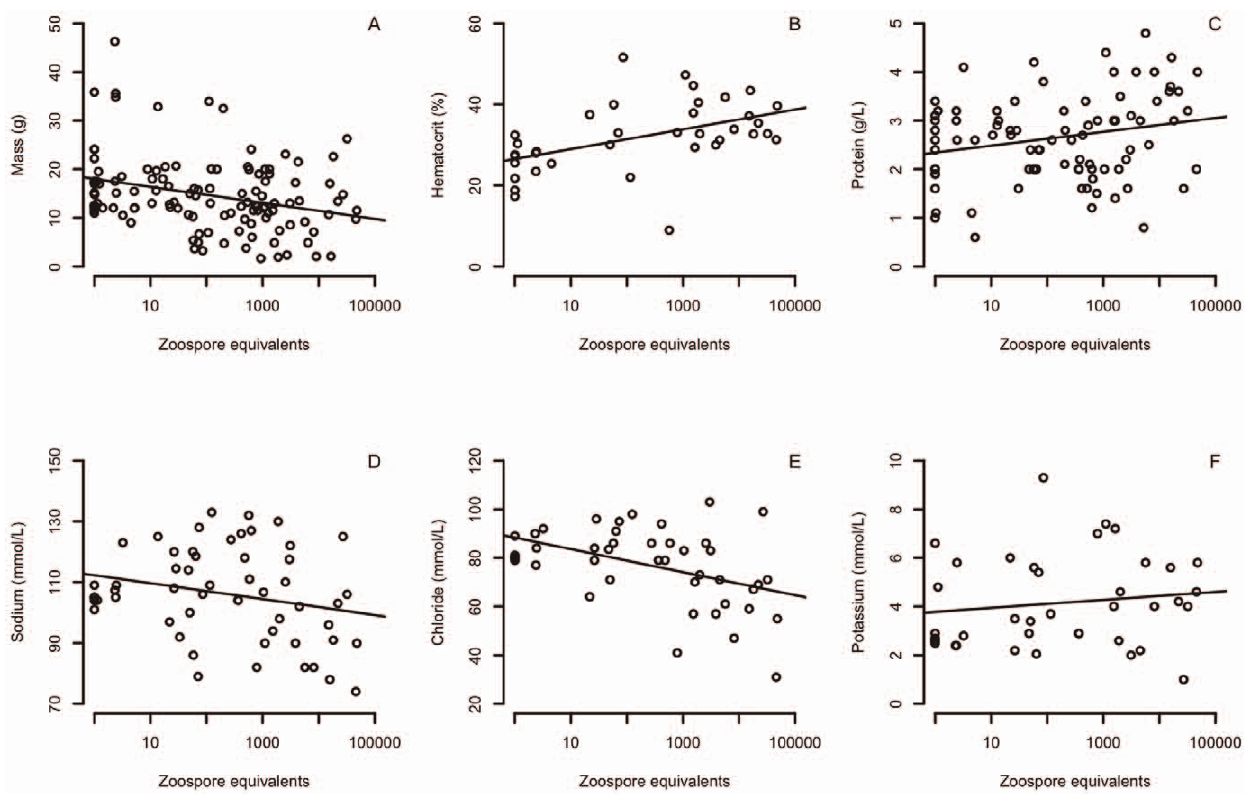
Figure 3. Mass and blood biochemistry parameters collected from mountain yellow-legged frogs during a chytridiomycosis outbreak. A–C) Mass, hematocrit and protein values suggest dehydration in frogs with high loads of Batrachochytrium dendrobatidis ( Bd ). D–F) Plasma electrolyte concentrations (sodium and chloride) indicate abnormalities in fluid and electrolyte balance in frogs with high Bd -loads.